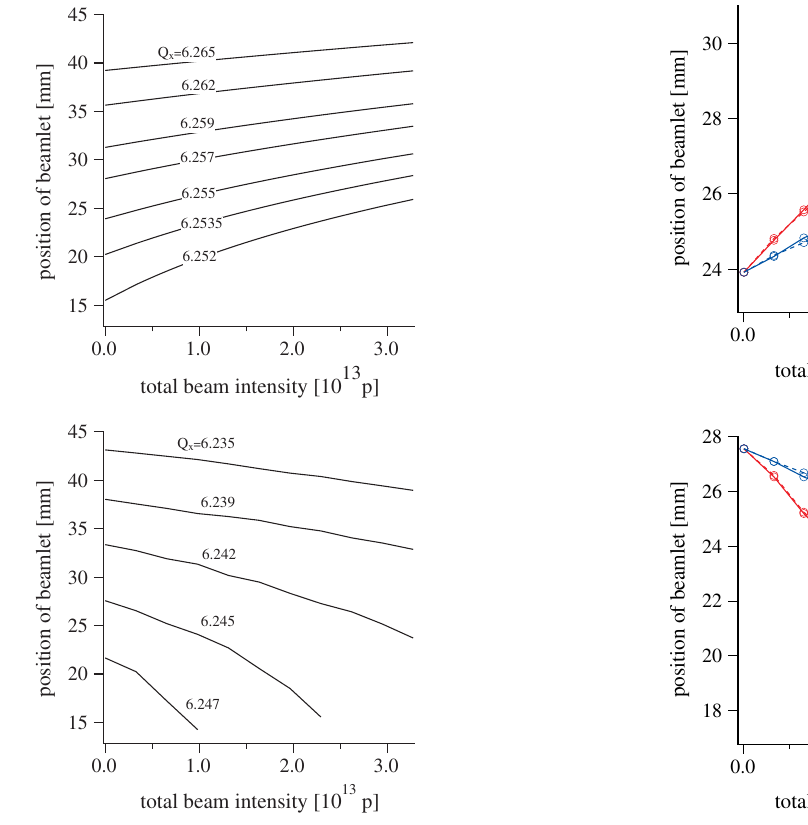
FIG. 9. Dependence of a beamlet ’ s position on the total FIG. 10. Beamlet ’ s position as a function of the total beam intensity. Several values of the horizontal tune, generating intensity. The impact of the different electric boundary conditions < 0 , different beam positions for zero intensity, are probed. The cases is small, but visible. The cases corresponding to h 2 ; 0 ¼ 6 . 255 and h 0 , Q ¼ 6 . 245 are shown in the upper Q < 0 and h 2 > 0 are shown in the upper corresponding to h 2 2 ; 0 > ; 0 ; 0 x x ¼ 6 . 247 and 6.245, the and lower plots, respectively. For Q and lower plot, respectively. The contribution of the various x sources of intensity-dependent position shifts is indicated by the fixed points disappear for the largest intensity reported in the plot. various curves. The beam momentum is 14 GeV =c Parallel plates electric boundary conditions are included. The beam momentum is 14 GeV =c .